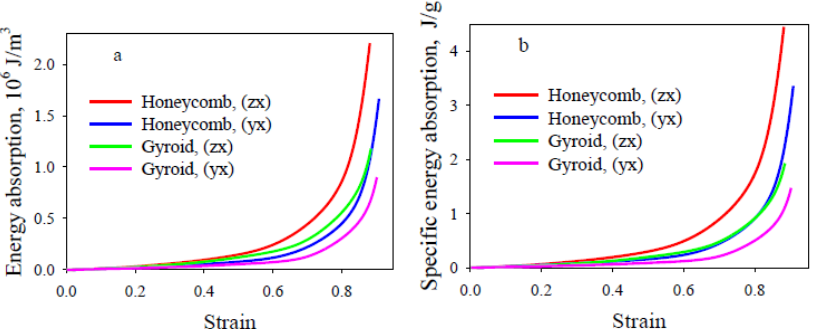
Figure 6. Energy absorption ( a ) and specific energy absorption ( b ) of the lattice flexible TPU struc- tures.